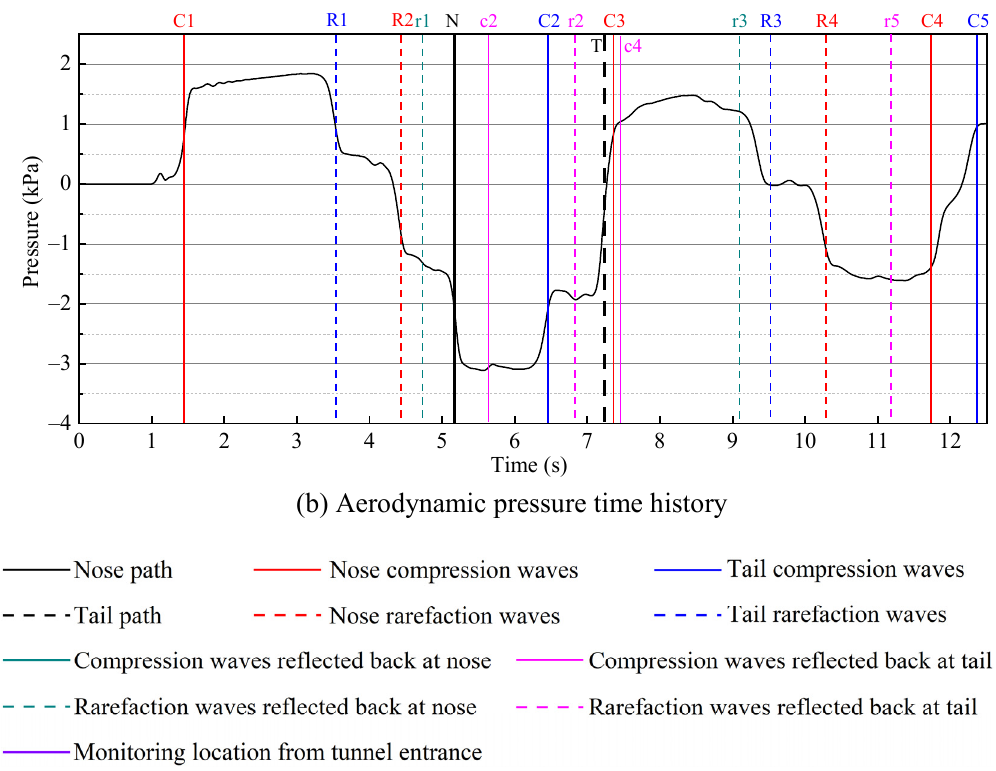
Figure 16. Relationship between wave diagram and aerodynamic pressure of monitoring point 10- V in Stage II.